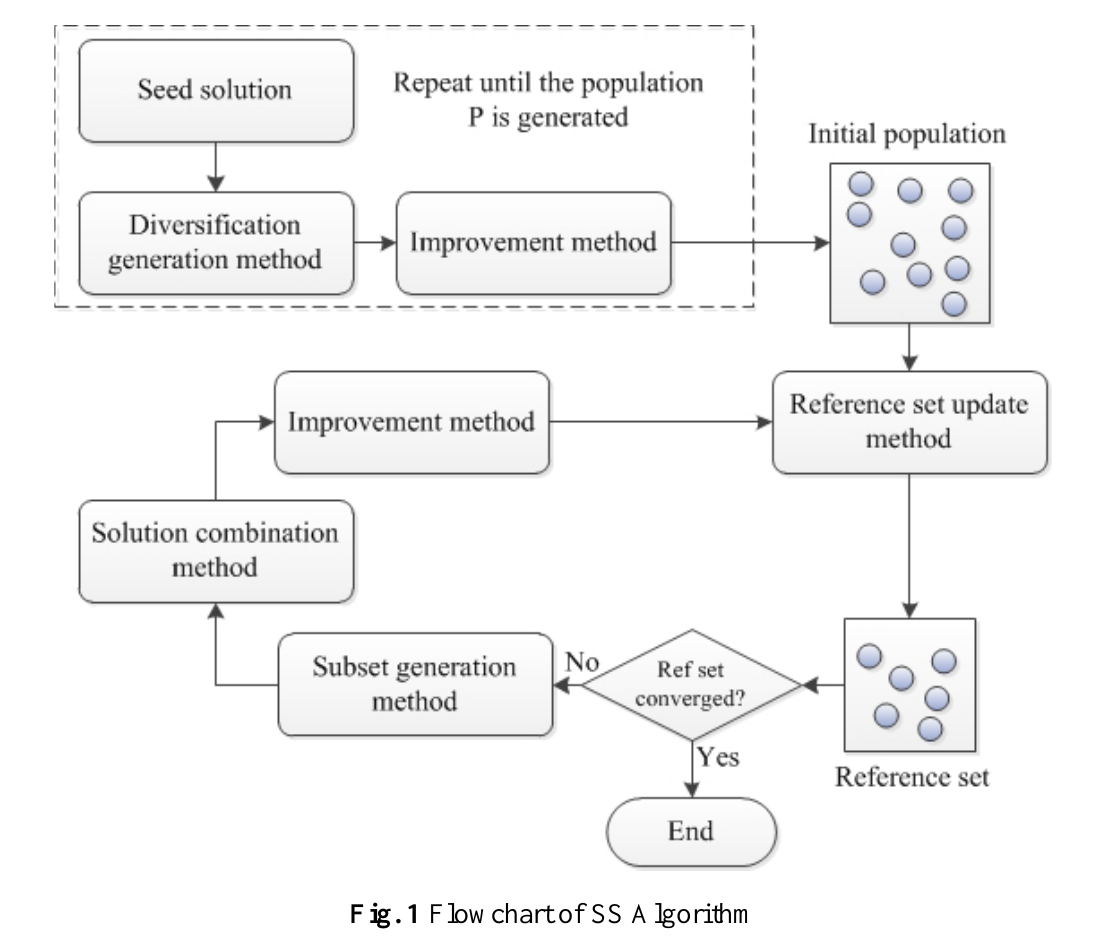
Fig. 1 Flowchart of SS